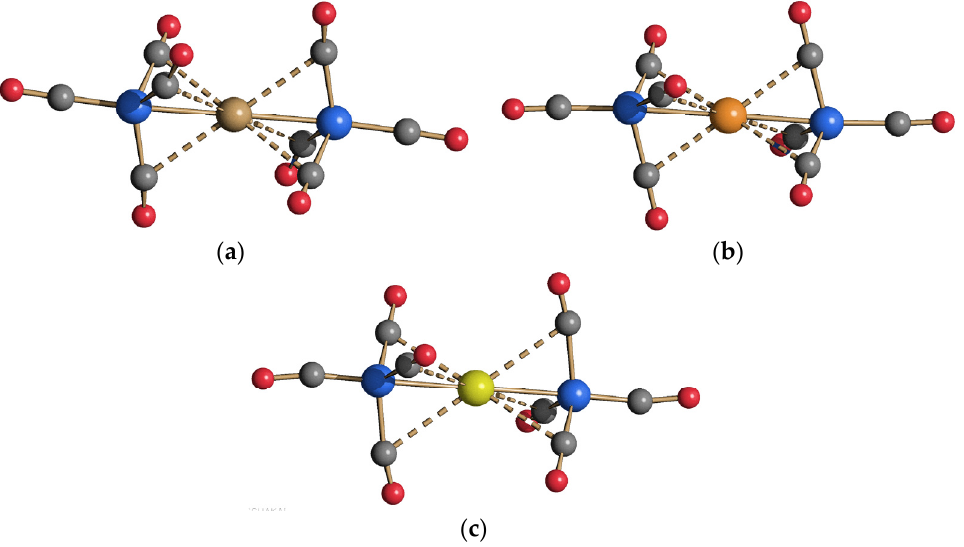
Figure 3. Molecular structures of ( a ) [Cu{Co(CO) 4 } 2 ] − ( 2 ), ( b ) [Ag{Co(CO) 4 } 2 ] − ( 3 ), and ( c ) [Au{Co(CO) 4 } 2 ] − ( 4 ). Sub Van der Waals M···C(O) contacts are represented as fragmented lines (brown, Cu; orange, Ag; yellow, Au; blue, Co; red, O; grey, C). All the anions adopt the TBP-TBP staggered structure. a As found in [NEt 4 ]( 2 ). b As found in [NEt 4 ]( 3 ). c As found in [NEt 4 ]( 4 ). d As found in Na 2 ( 5 )·C 4 H 6 O 2 . e As found in [PPN] 2 ( 5 )·C 5 H 12 . f As found in [NBu 4 ] 2 ( 5 ). g As found in [NMe 4 ] 2 ( 5 ). h Co t refers to Co(CO) 4 groups bonded to a single M (terminal position), whereas Co b refers to Co(CO) 4 groups bonded to two M atoms (bridging position). Table 1. Main bond distances (Å) and angles (°) for [Cu{Co(CO) 4 } 2 ] − ( 2 ), [Ag{Co(CO) 4 } 2 ] − ( 3 ), [Au{Co(CO) 4 } 2 ] − ( 4 ) and [Ag 2 {Co(CO) 4 } 4 ] 2 − ( 5 ).